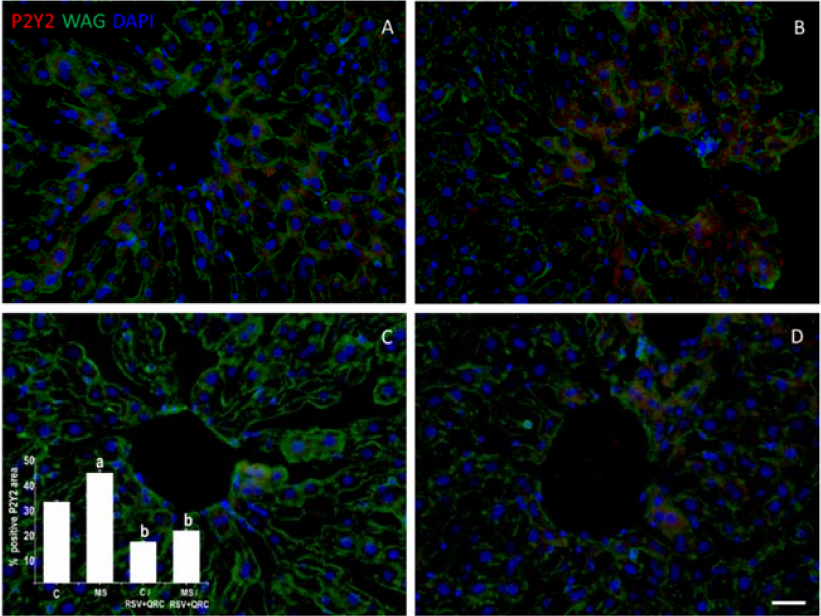
Figure 3. Effect of administration of RSV + QRC on the expression of the P2Y2 receptor in the liver from Control and MS rats. The detection of P2Y2 immunostaining (red) was located in hepatocytes around of central vein. Wheat germ agglutinin (WAG) labeled with Oregon Green ® 488 was used to label the membranes and DAPI for nuclei. The graph with the values of the percentage of positive P2Y2 area is in the lower-left corner. a p < 0.05 vs. Control: b p < 0.01 vs. MS group. Panel ( A ) = Control group, Panel ( B ) = metabolic syndrome (MS) group, Panel ( C ) = Control/RSV + QRC group, Panel ( D ) = MS/RSV + QRC group. Bar = 50 µ